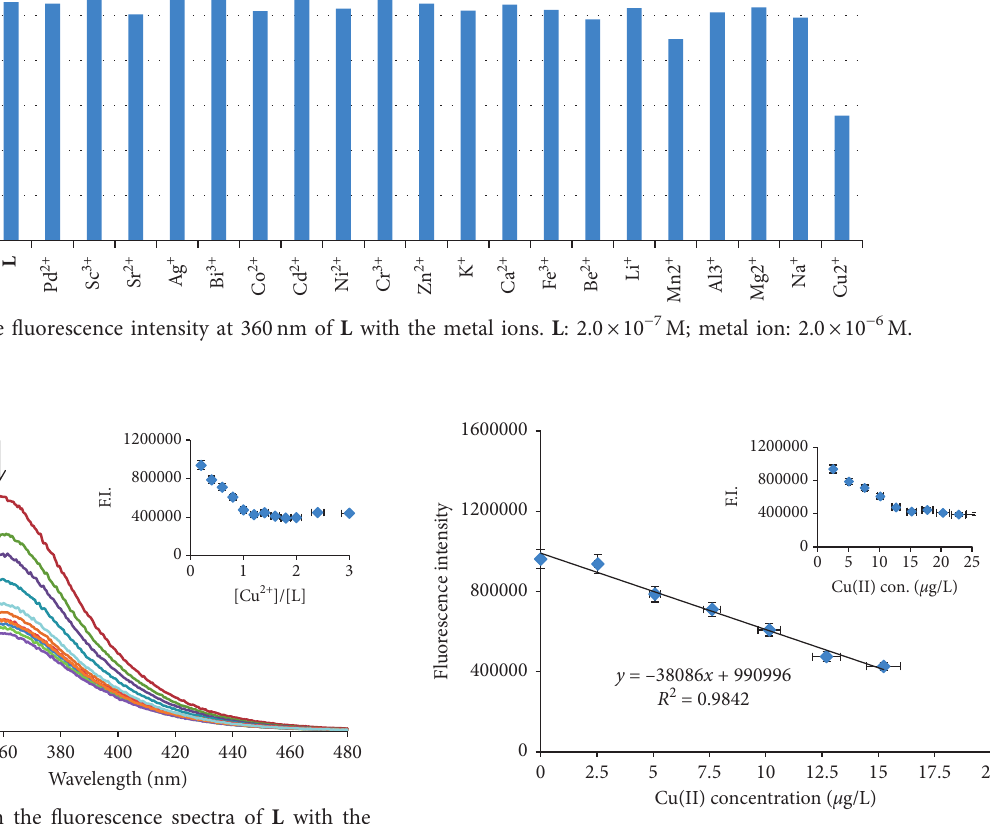
Figure 7: The change in the fluorescence intensity with the in- creasing Cu 2+ concentration at 360nm in acetonitrile-water (1 :1). L : 2.0 × 10 − 7 M. Inset: deviation from Beer’s law after 15 μ g/L of Cu 2+ concentration. Table 1: Analytical performance data for the Cu 2+ determination method.